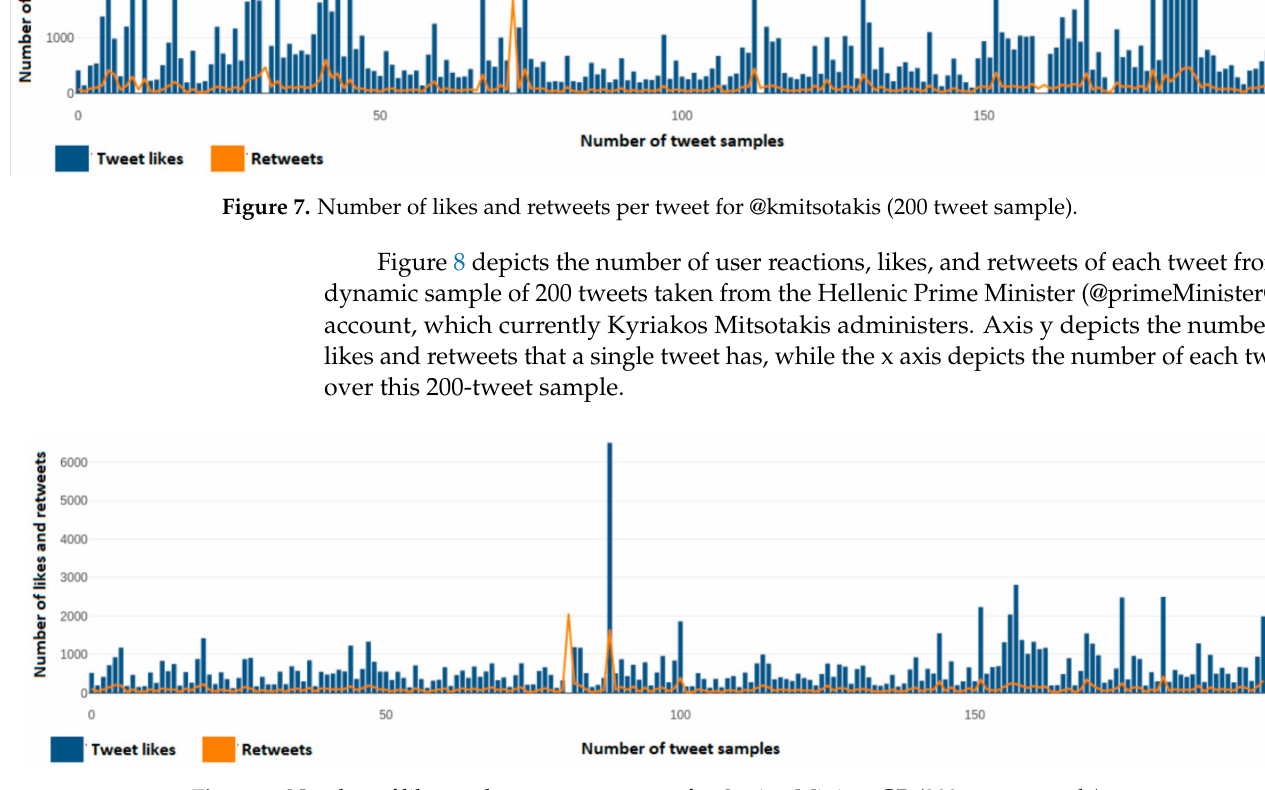
Figure 8. Number of likes and retweets per tweet for @primeMinisterGR (200 tweet sample). Figure 9 depicts the number of user reactions, likes, and retweets of each tweet from a dynamic sample of 200 tweets taken from Alexis Tsipras’ (@atsipras) account. Axis y depicts the number of likes and retweets that a single tweet has, while the x axis depicts the number of each tweet over this 200-tweet sample.